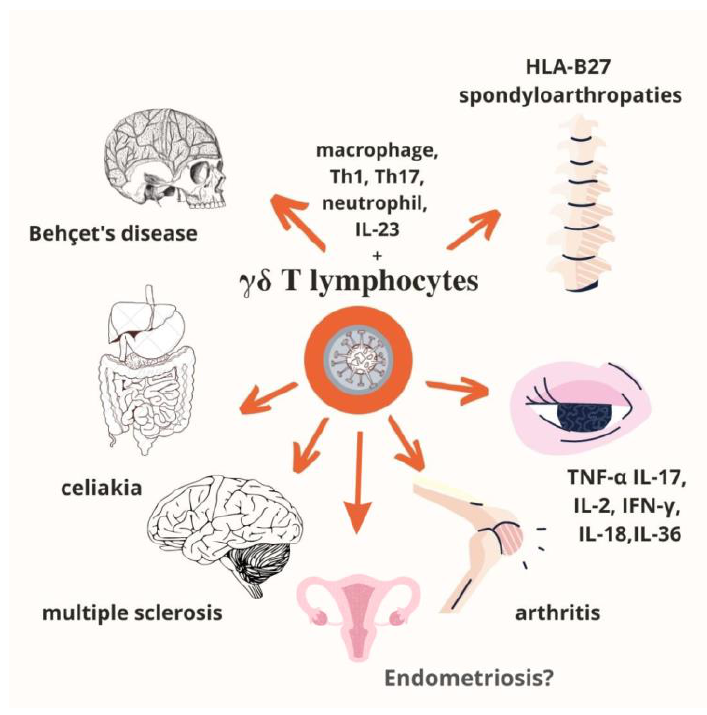
Figure 2. Autoimmune diseases associated with γδ T lymphocytes [35].